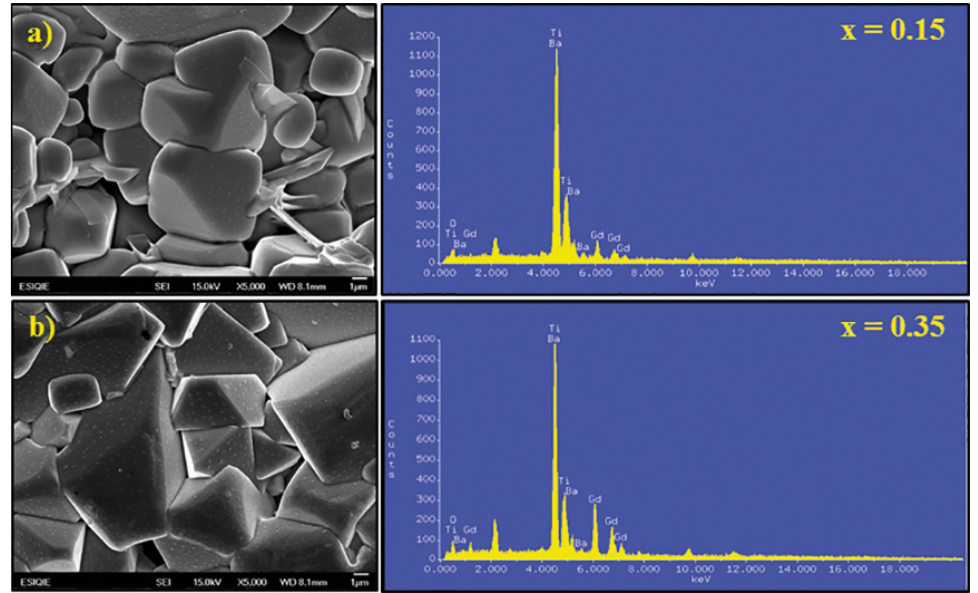
, doped with different Gd 3+ . a) x= 0.15, and b) x= 0.35. 3 Table 1: Semiquantitative chemical compositions (SEM-EDS) of powders sintered at 1400 °C, 0 ≤ x ≤ 0.35 (wt.%).